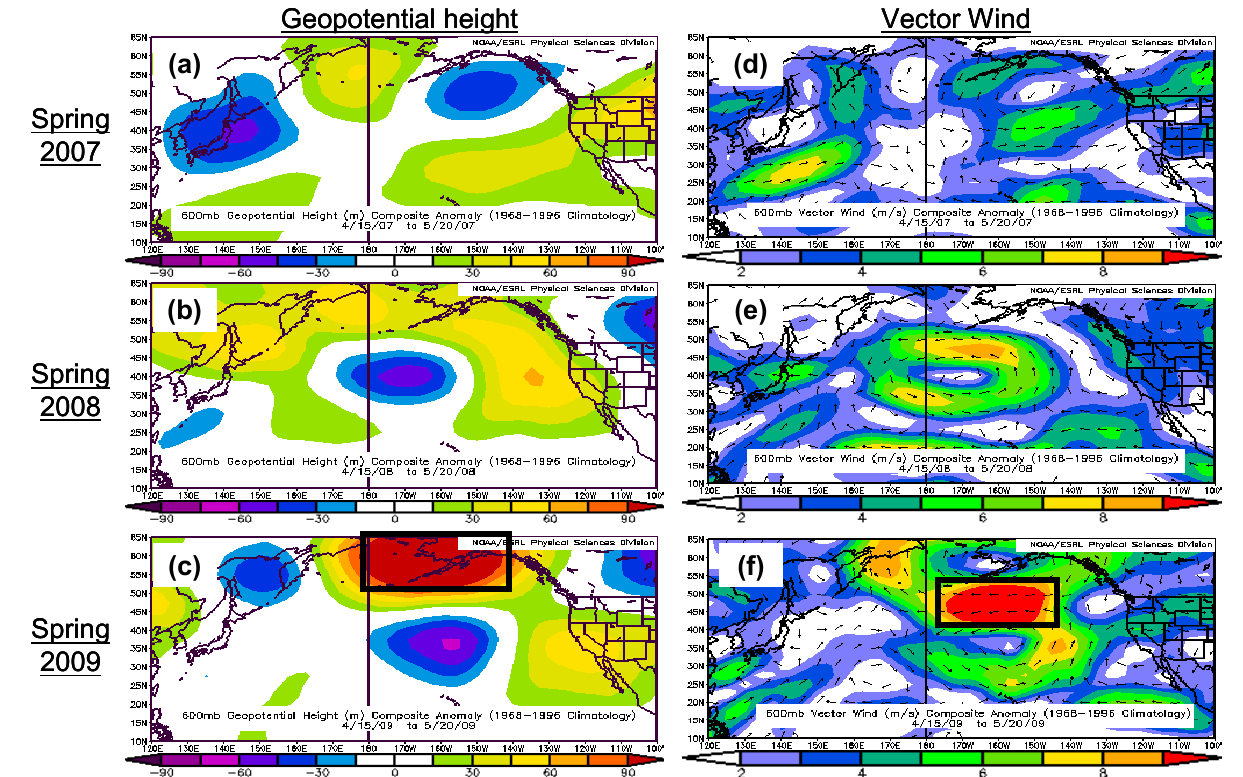
Figure 8. Springtime FT (600 hPa) anomalies (from NCEP reanalysis) of (left) geopotential height and (right) vector winds for (top) 2007, (middle) 2008, and (bottom) 2009. The black boxes in (c) and (f) indicate regions where substantial anomalies occurred during spring 2009.